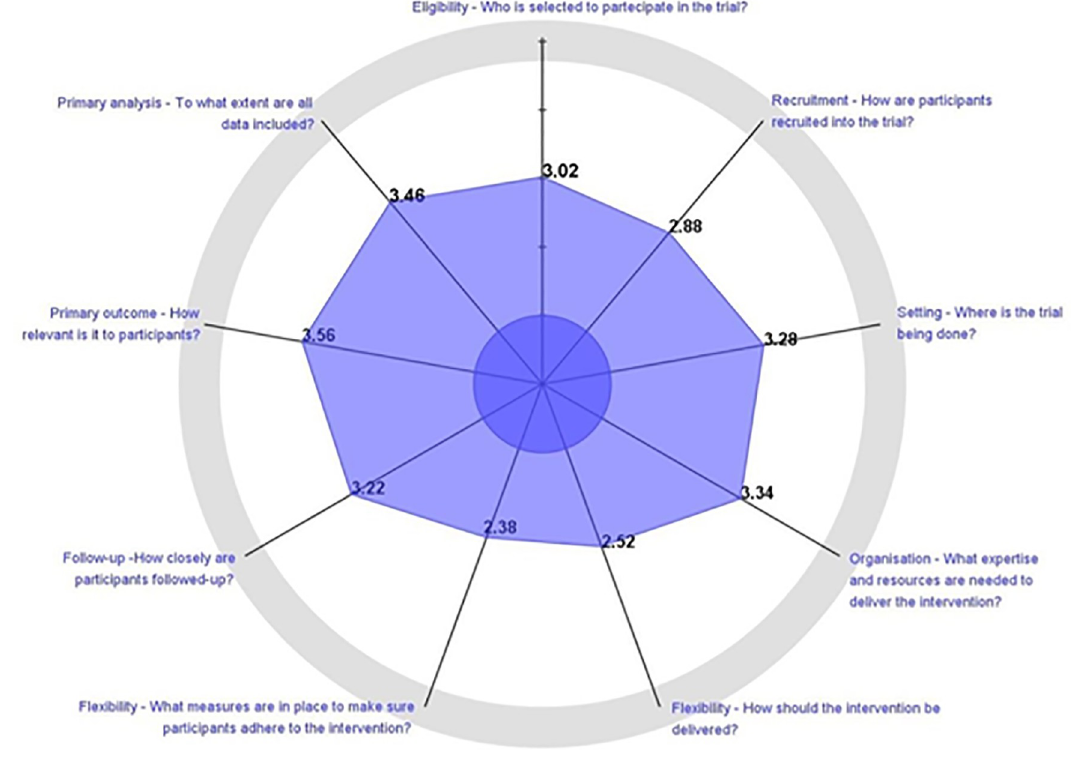
Fig 2. Cumulative PRECIS